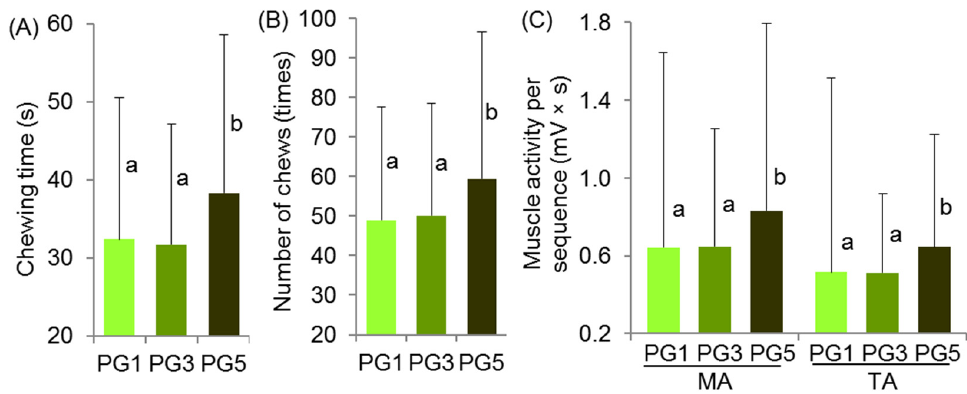
Figure 3. Electromyography data on PG chewing time (A), number (B), and activity of the masseter (MA) and temporal (TA) muscles (C). Means with standard deviations are given. Differences are significant ( p < 0.05) between means labeled with different lowercase letters (a and b) ( n = 16). As known, the incorporation of saliva into a bolus while chewing transforms the in- itial value of moisture content in solid or semisolid foods to prepare a ready-to-swallow bolus in the mouth [37]. A gravimetrical analysis of saliva content in the bolus formed from the PGs revealed that saliva uptake varied between 22.6 and 29.1 wt% in pectin hy- Table 5. Salivary parameters and viscosity of the bolus from PG1, PG3, and PG5. Saliva Parameters Viscosity Hydrogel